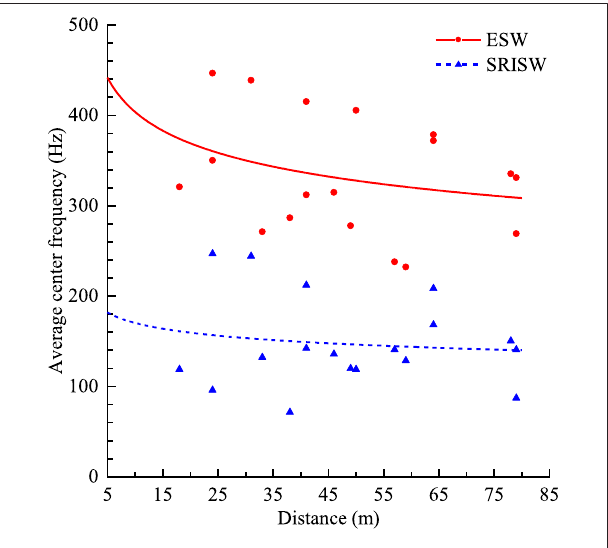
the separated seismic